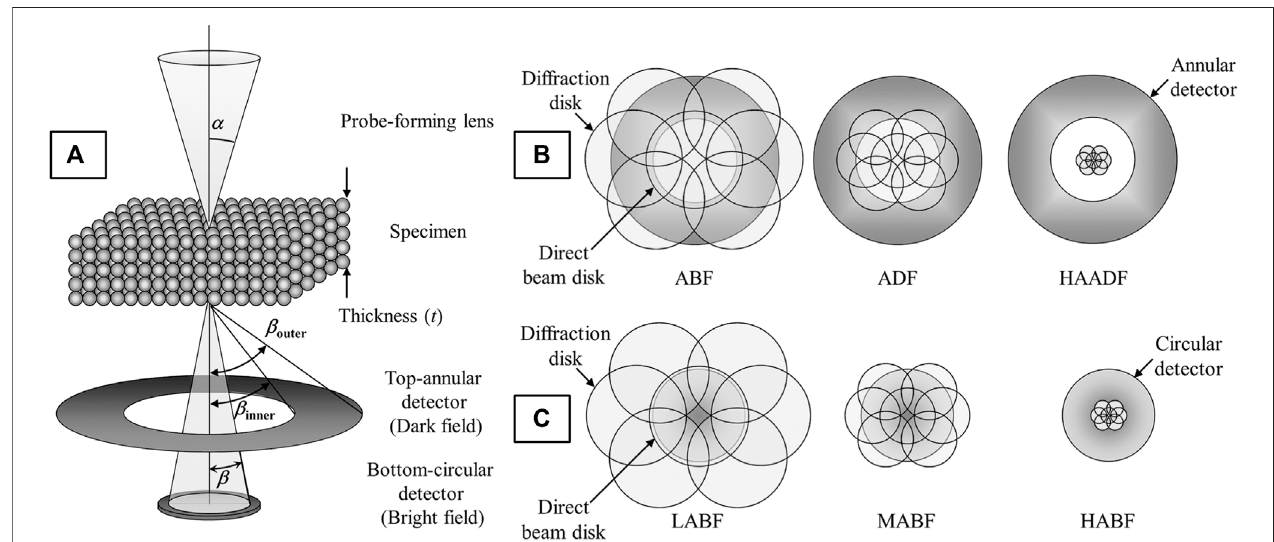
FIGURE 4 | Schematic of STEM detection con fi guration for (A) double-detector STEM imaging, (B) annular DF (ADF) detector under ABF, ADF, and HAADF conditions,and (C) acircularBFdetectorunderlow,medium,andhighABFconditions(LABF,MABFandHABF,respectively).Thecameralength(CL)isshortenedfrom left to right in (B,C) . Reproduced from reference (Kotaka,